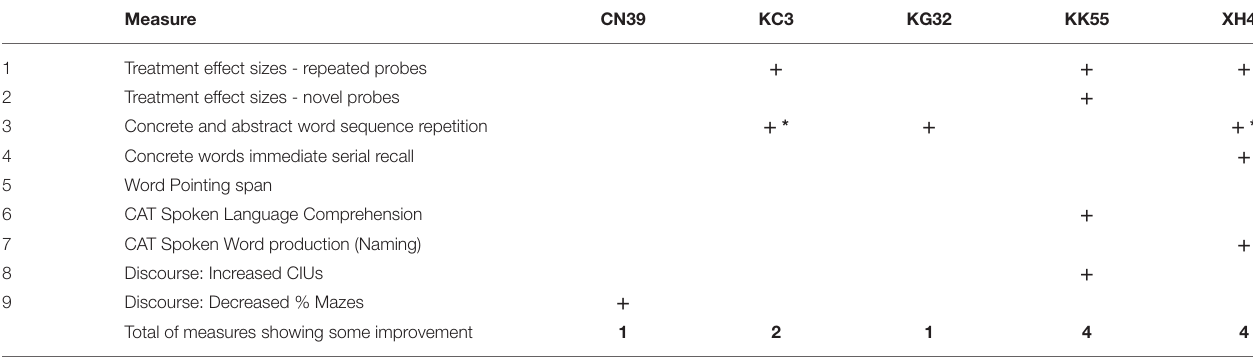
TABLE 5 | Summary of gains made on the outcome